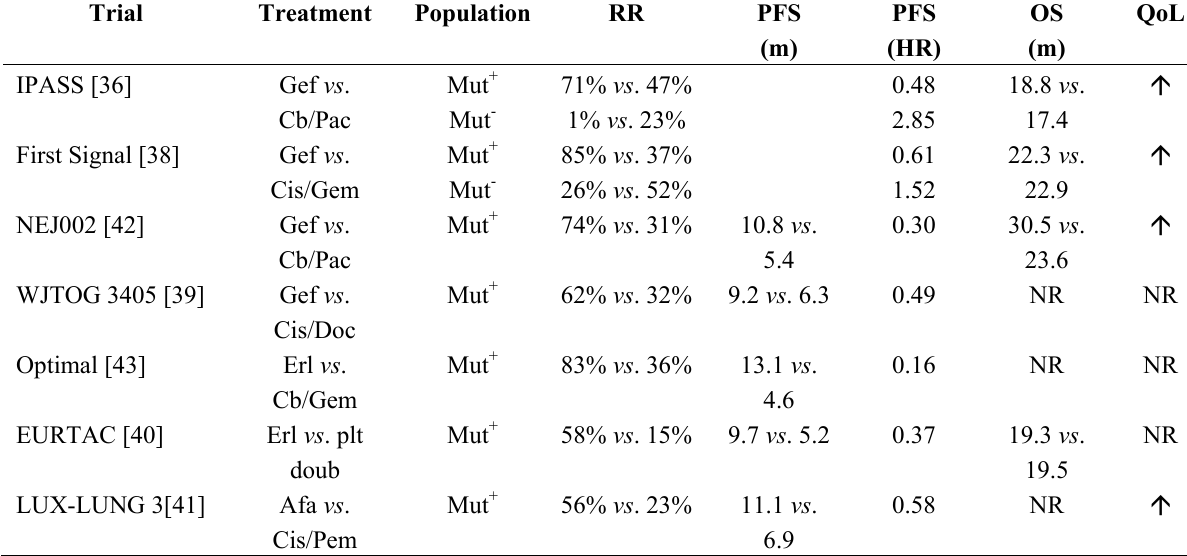
Table 1. Summary of first-line trials of Epidermal Growth Factor Receptor (EGFR) tyrosine kinase inhibitor (TKI) versus chemotherapy.